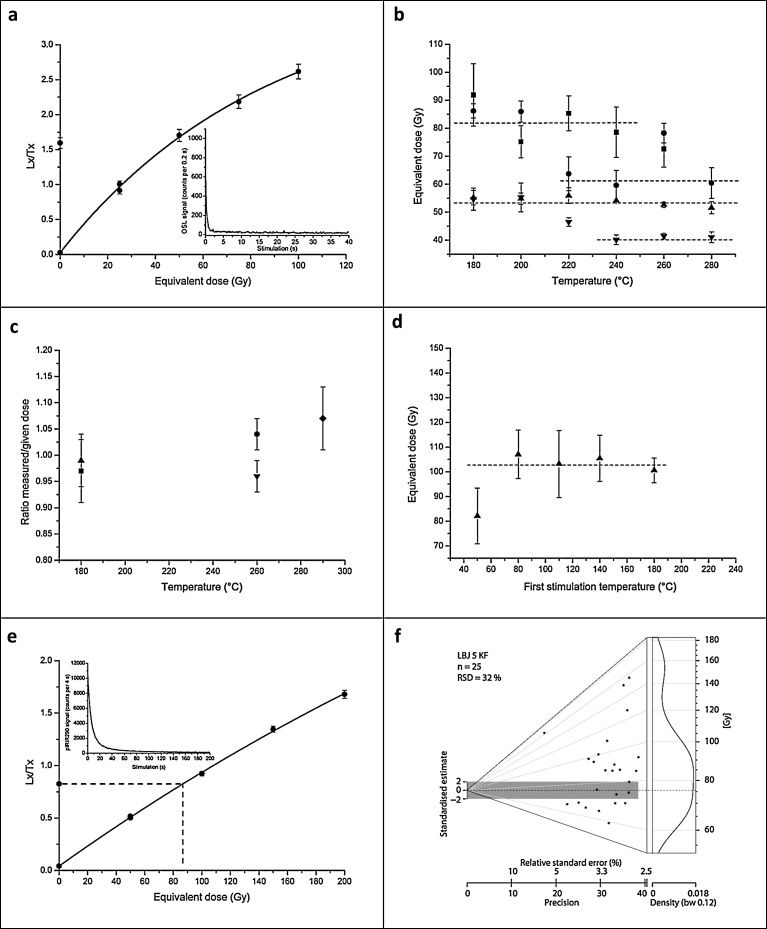
La Boja OSL dating. Analytical data. a. Representative quartz dose response and decay curve for sample C-L3905. b. Preheat plateau tests indicating that the equivalent dose is independent from temperature treatment between: 180 and 240 °C (C-L3901, square); 220 and 280 °C (C-L3904, circle); 180 and 280 °C (C-L3905, triangle); 240 and 280 °C (C-L3906, inverted triangle). c. Dose recovery tests showing that a laboratory given dose was best recovered using a temperature of 180 °C for samples C-L3901 and C-L3905 and of 260 °C for samples C-L3904 and C-L3906. d. Prior IR stimulation temperature tests carried out for feldspar sample C-L3905 indicating a plateau between 80 and 180 °C; 80 °C was chosen as prior-IR stimulation temperature. e. Representative feldspar pIRIR290 dose response and decay curves of sample C-L3905. f. Dose distribution of feldspar sample C-L3905 displayed as abanico plot; the dashed line is the MAM equivalent dose.